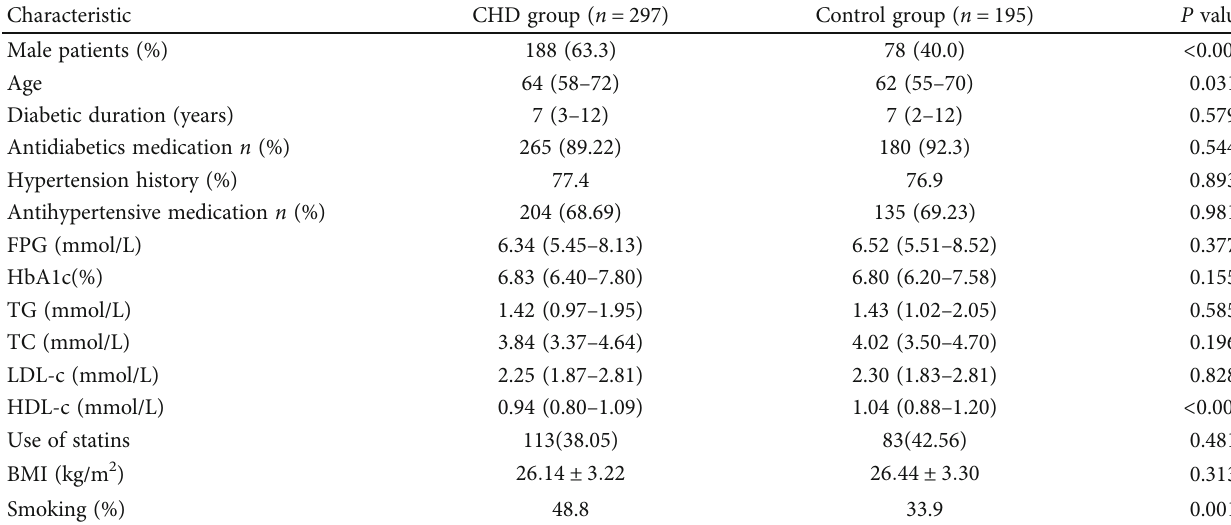
Figure 1: Flowchart of the coronary atherosclerosis screening. Abbreviations: T2D: type 2 diabetes; CAG: coronary arteriography; CAD: coronary artery disease; SVD: single-vessel disease; DVD: dual-vessel disease; TVD: triple-vessel disease. Table 1: Characteristics of CHD cases and